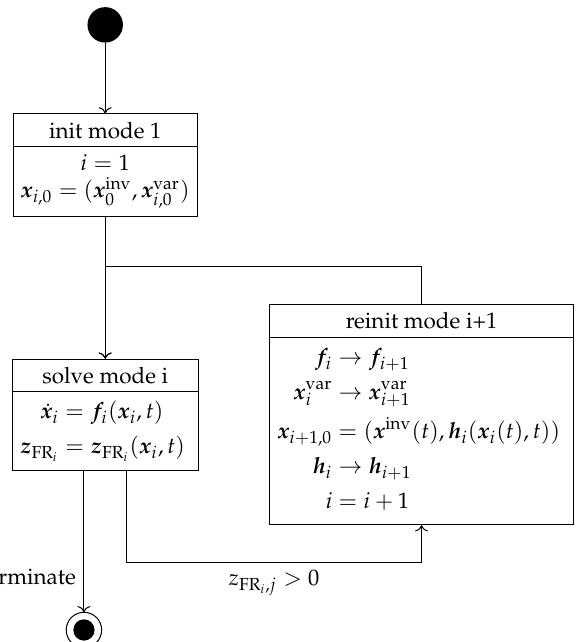
Figure 6. State machine of segmented simulation. The first mode i = 1 is initialized with its start values. The ODEs of the actual mode i are solved until they are terminated or interrupted by a full restart zero-crossing event indicator z FR that becomes positive. In the latter case, the model is i , j re-initialized in mode i + 1. Hereby, variant variables can appear or disappear. The number of modes is unknown